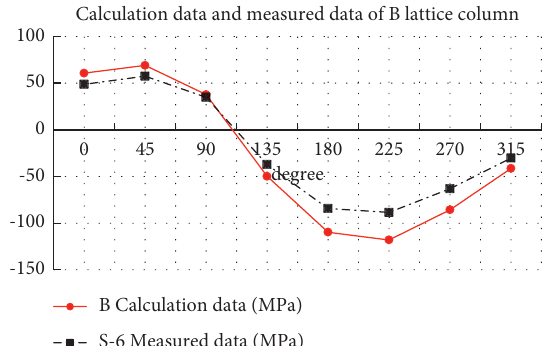
Figure 14: Comparison chart of calculated stress and measured stress of B lattice column.